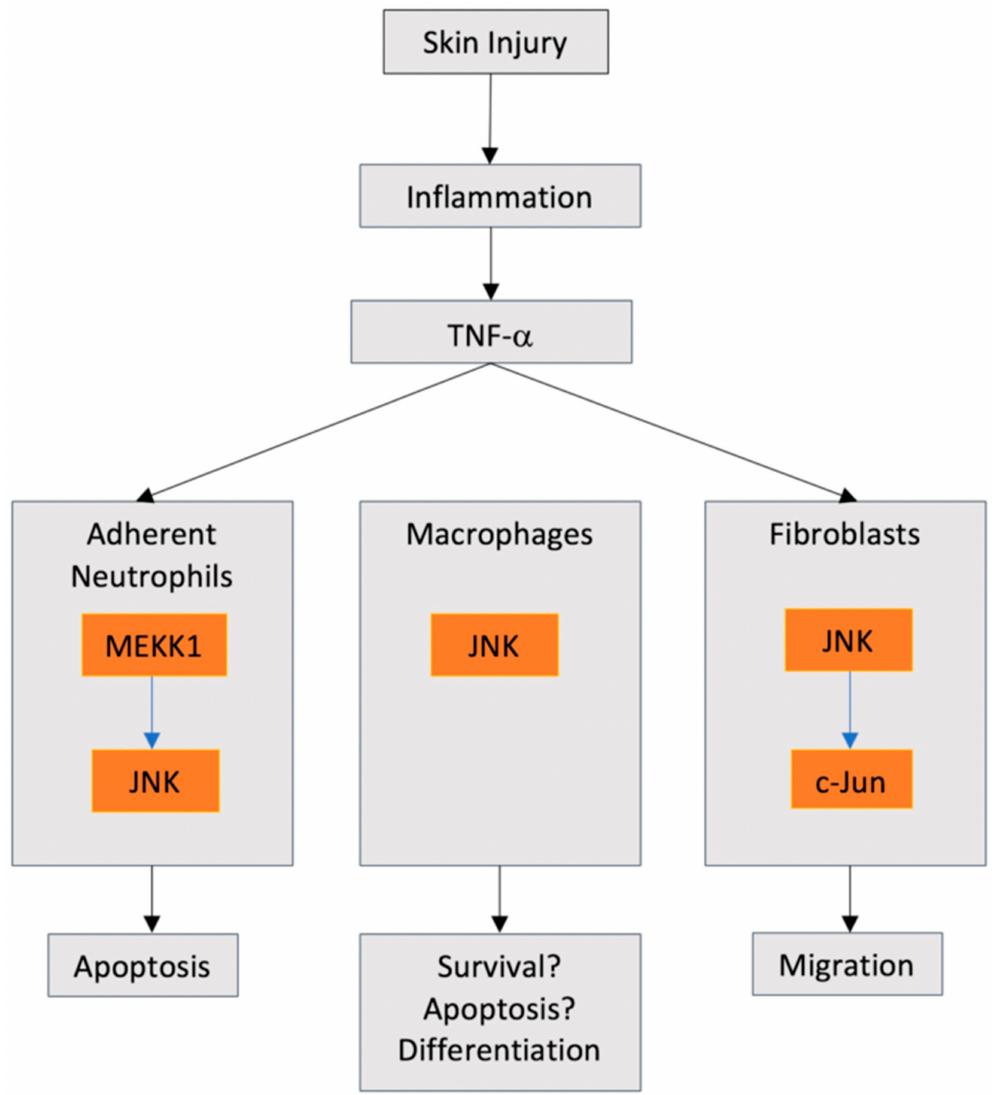
Figure 1. Possible interplay of c-Jun N-terminal kinases (JNK) signaling in the inflammatory stage of skin healing. Production of tumor necrosis factor α (TNF- α ) has been demonstrated to have defined roles in neutrophils and fibroblasts through JNK signaling, with the role of JNK signaling in macrophage biology in response to TNF- α less well defined in healing